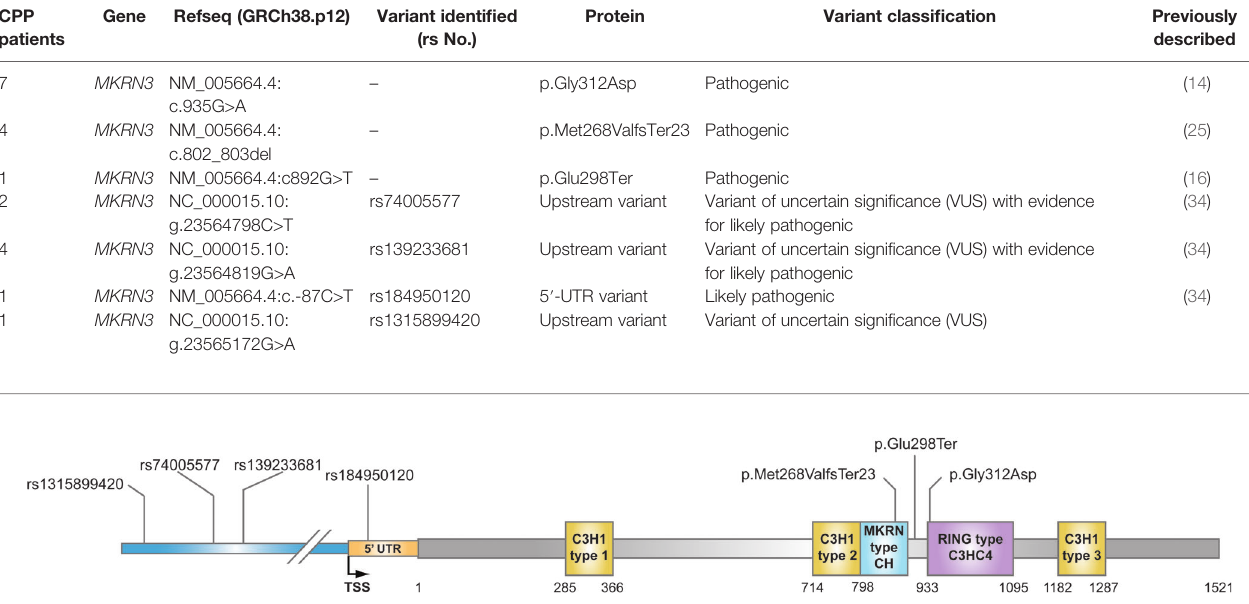
TABLE 2 | MKRN3 pathogenic and likely pathogenic variants identi fi ed in 20 non related females with CPP. CPP patients